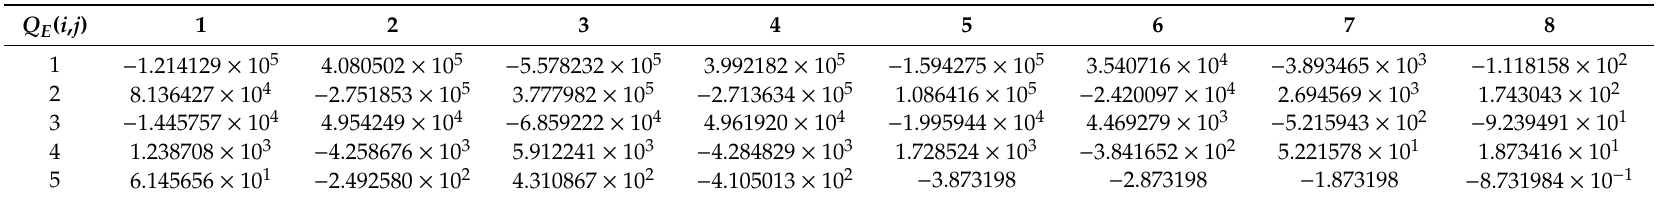
Table A3. The coe ffi cient matrix Q E